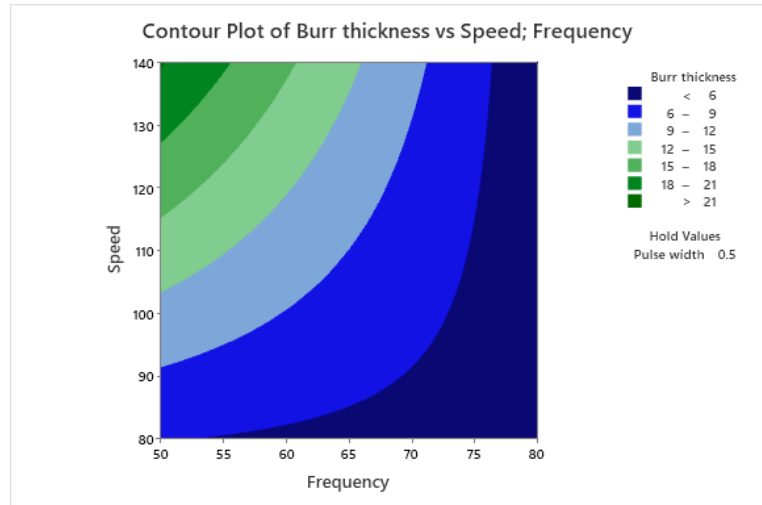
Figure 7. Pareto Chart of the Standardized Effects for Burr thickness.